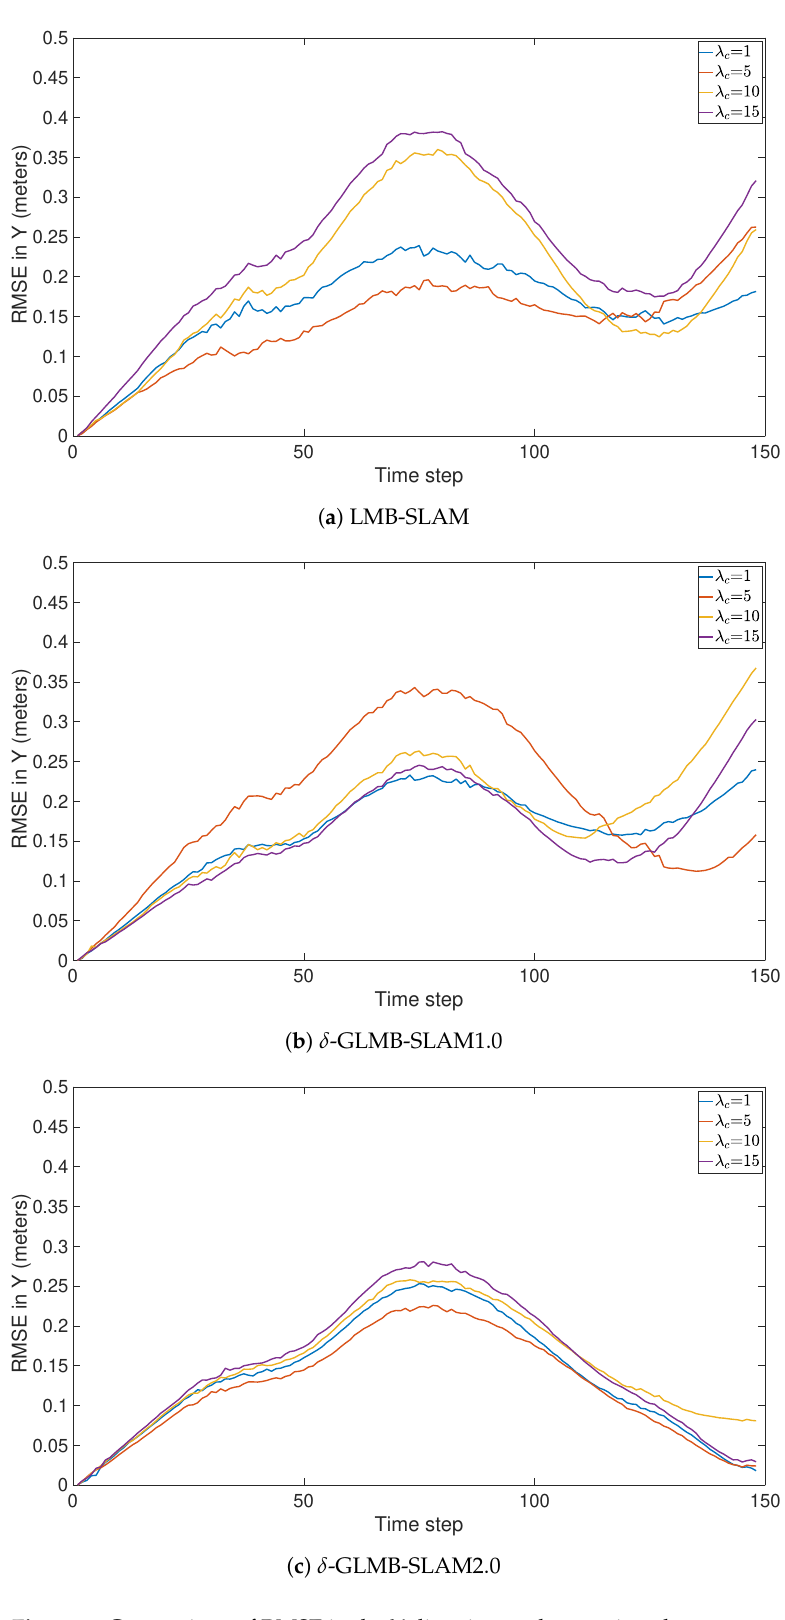
Figure 3. Comparison of RMSE in the Y direction under varying clutter